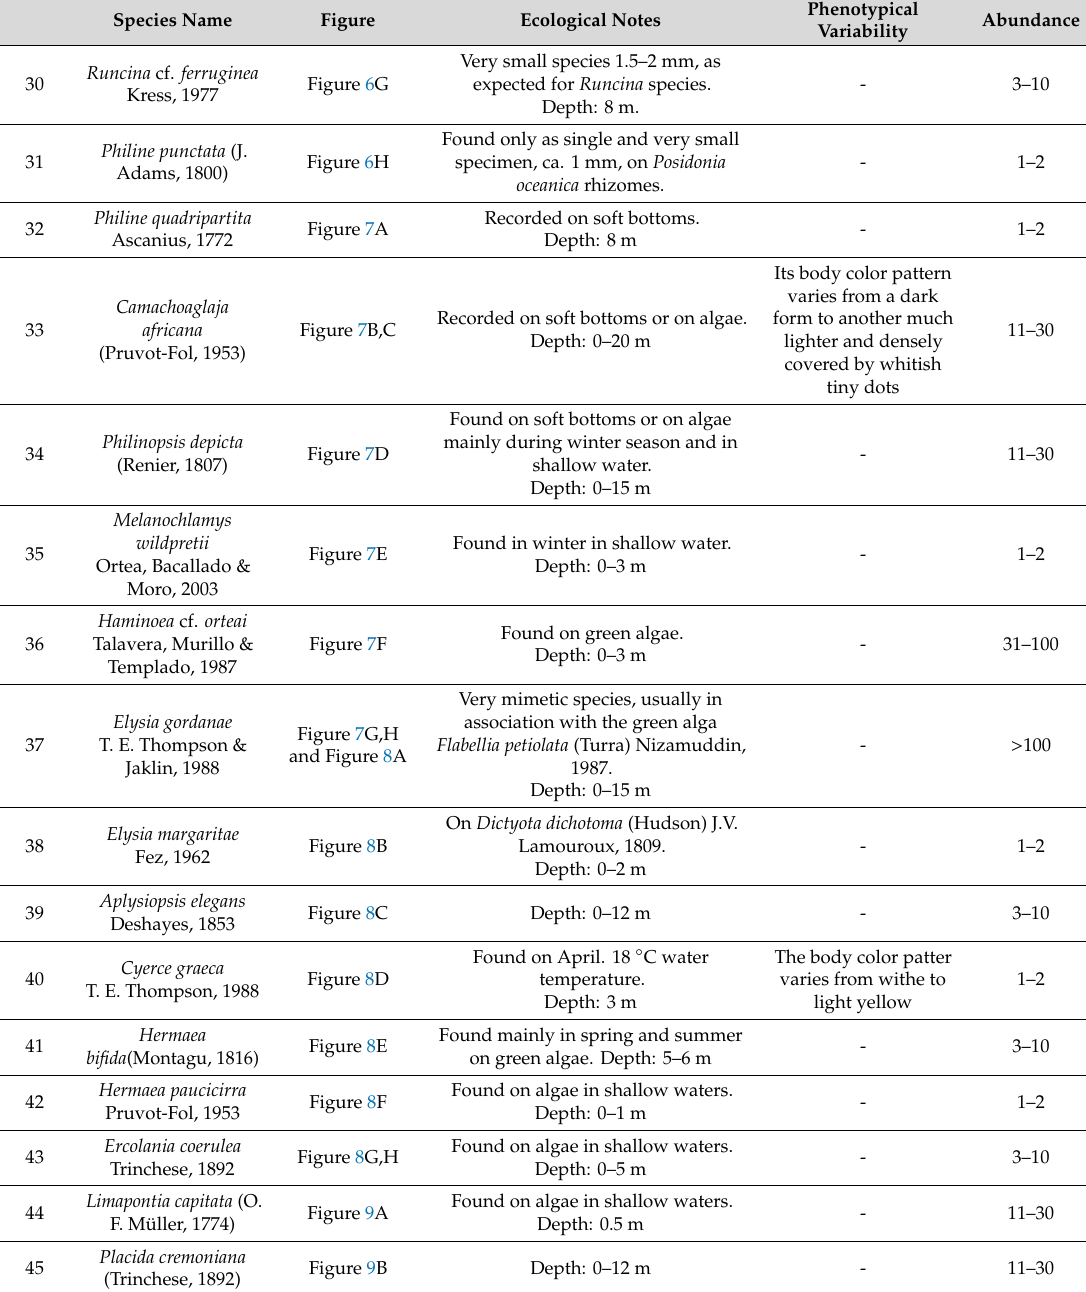
- - 1–2 - 1–2 Its body color pattern varies from a dark form to another much lighter and densely covered by whitish tiny dots - - 1–2